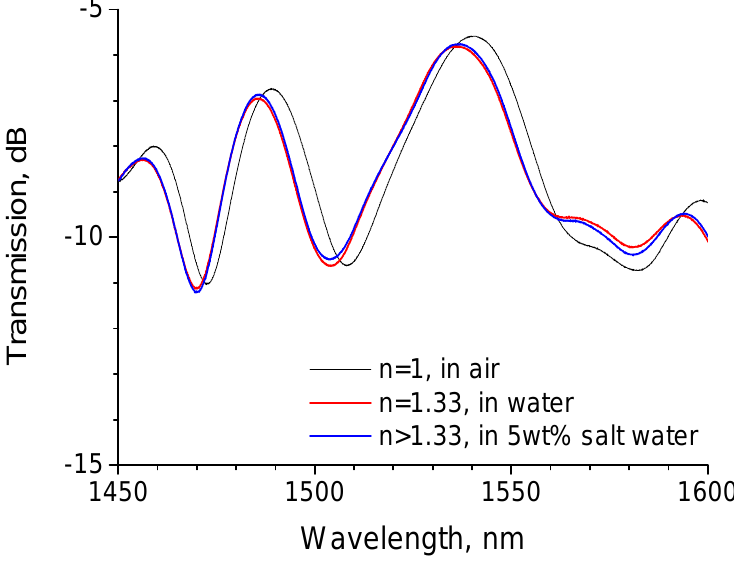
Figure 8. Discrimination of water from saline water using a 20-mm-long LPG having a bend radius of 43